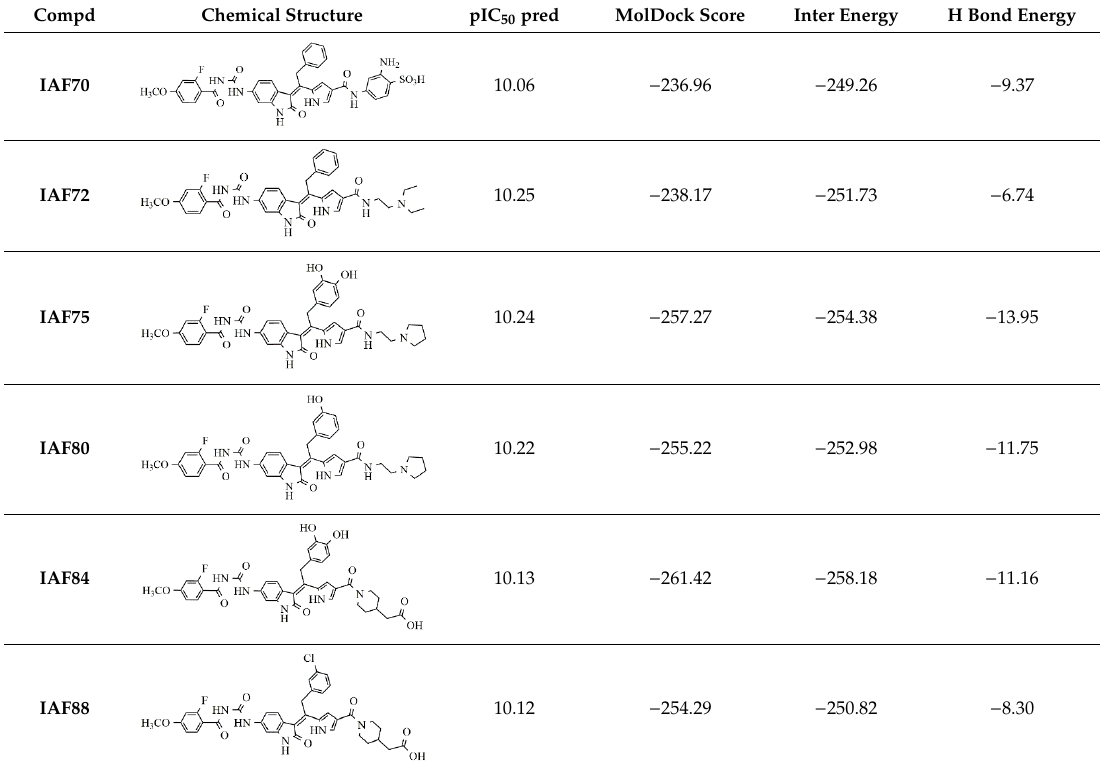
Table 4. Chemical structures, predicted pIC 50 values, MolDock Scores (kcal mol − 1 ), pose-protein interaction (kcal mol − 1 ) and hydrogen bond interactions (kcal mol − 1 ) for the most promising derivatives against FLT3.